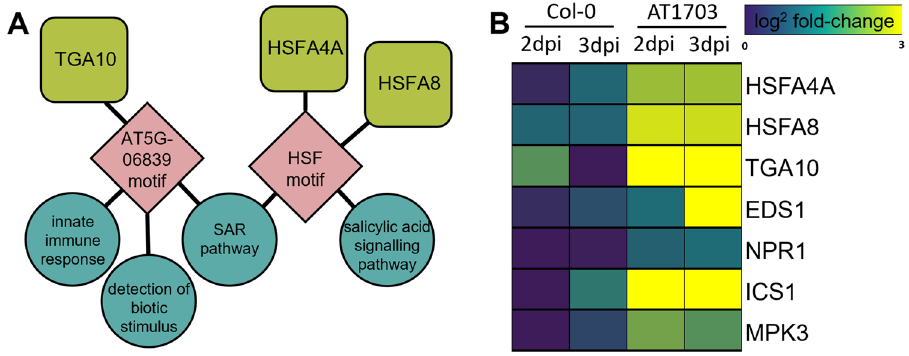
Figure 4. Differential expression and transcription factor network analysis of up-regulated shared AT1703 gene set in response to S. sclerotiorum . ( A ) Predictive transcription factor network analysis in shared AT1703 shared gene set in response to S. sclerotiorum. Yellow-green rounded squares represent significantly up-regulated transcription factors identified in AT1703 gene set, pink diamonds represent transcription factor DNA binding motifs, teal circles represent GO terms, and edges between DNA motifs and GO terms represent enriched motif sequences involved in the regulation of the GO term. ( B ) Log 2 fold change of infected AT1703 and wild-type Col-0 at 2- and 3-days post inoculation relative to respective uninfected treatments .